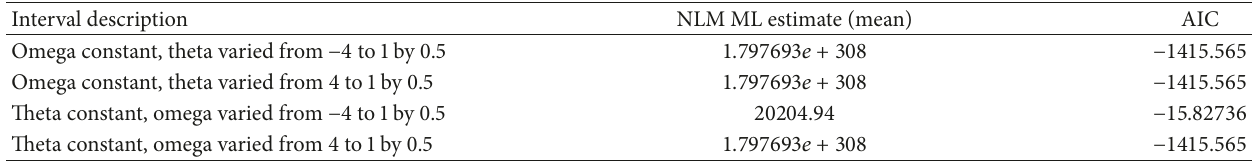
Table 11: Summary of results for lambda = 0.5, 𝑛 = 10 𝑖 , 𝑖 = 5 .